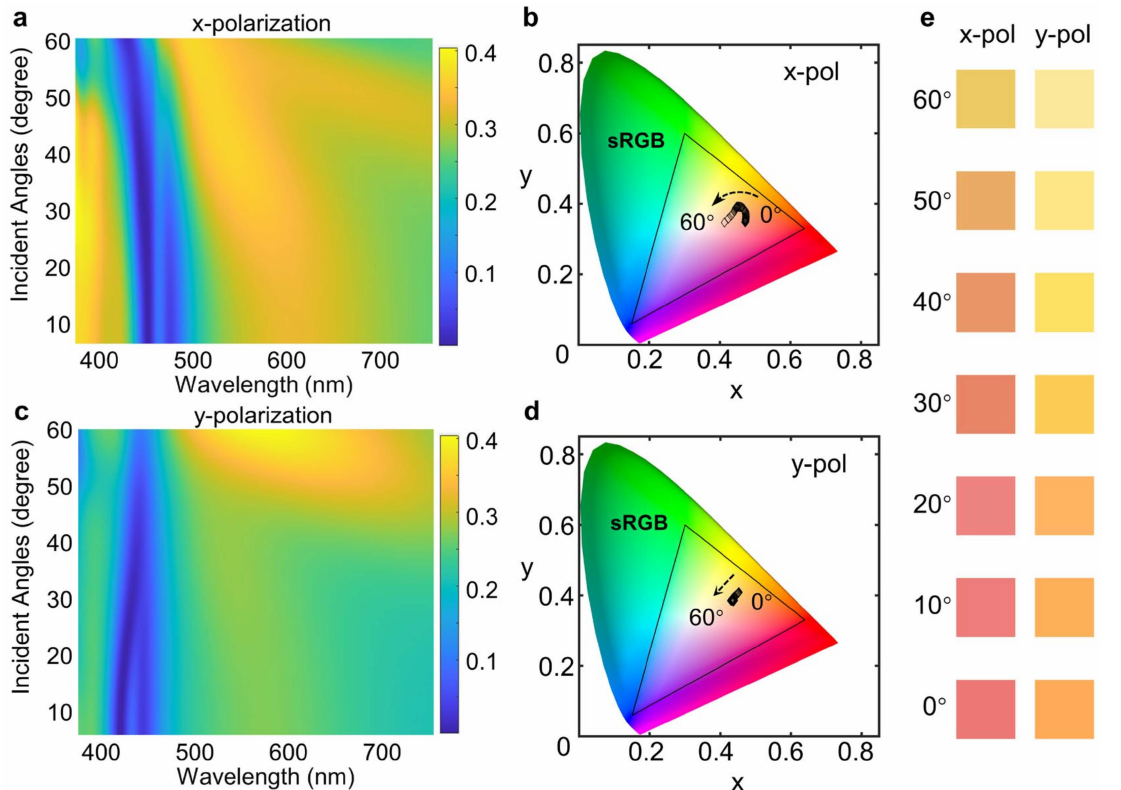
Figure 4. Simulated reflection spectra of S2 (D x = 120 nm, D y = 96 nm) under ( a ) x- and ( c ) y- polarization. Corresponding CIE 1931 chromaticity coordinates under ( b ) x- and ( d ) y-polarization. ( e ) Corresponding colors for varying incident angles from 0 ◦ to 90 ◦ with 10 ◦